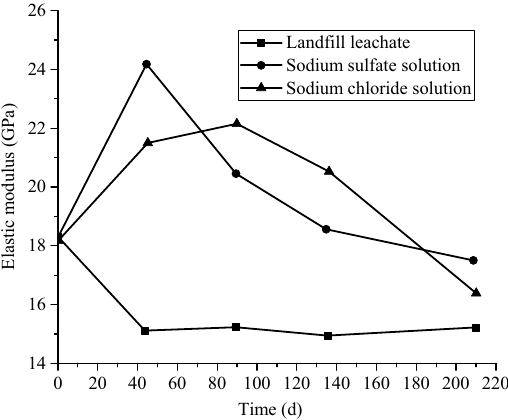
Figure 10. Elastic modulus of groups HLLN, NSSN, and NSCN after